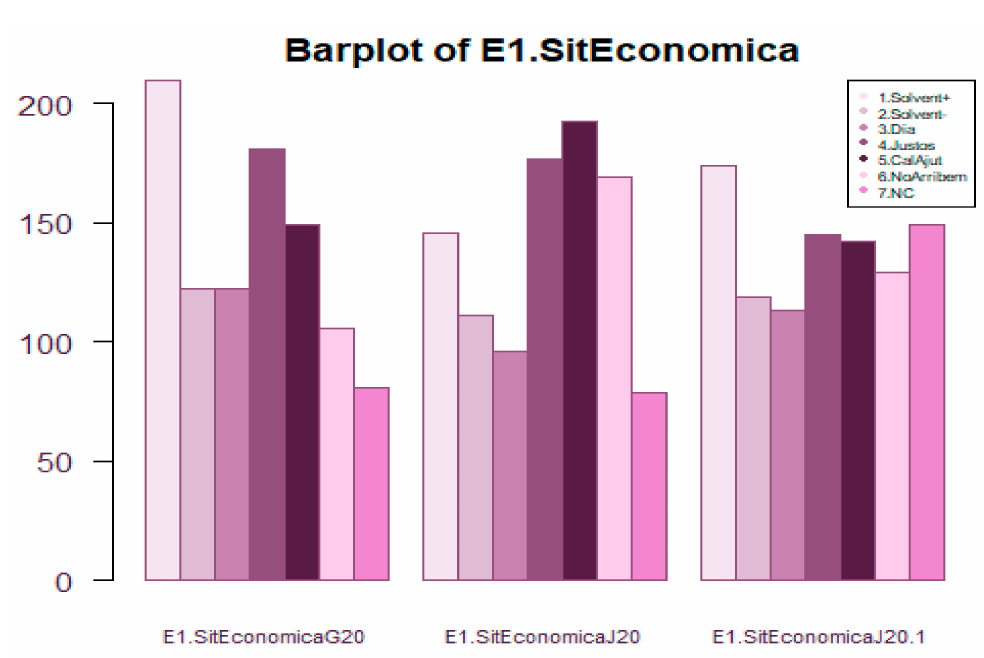
Figure 10. Multiple bar plot of Economic